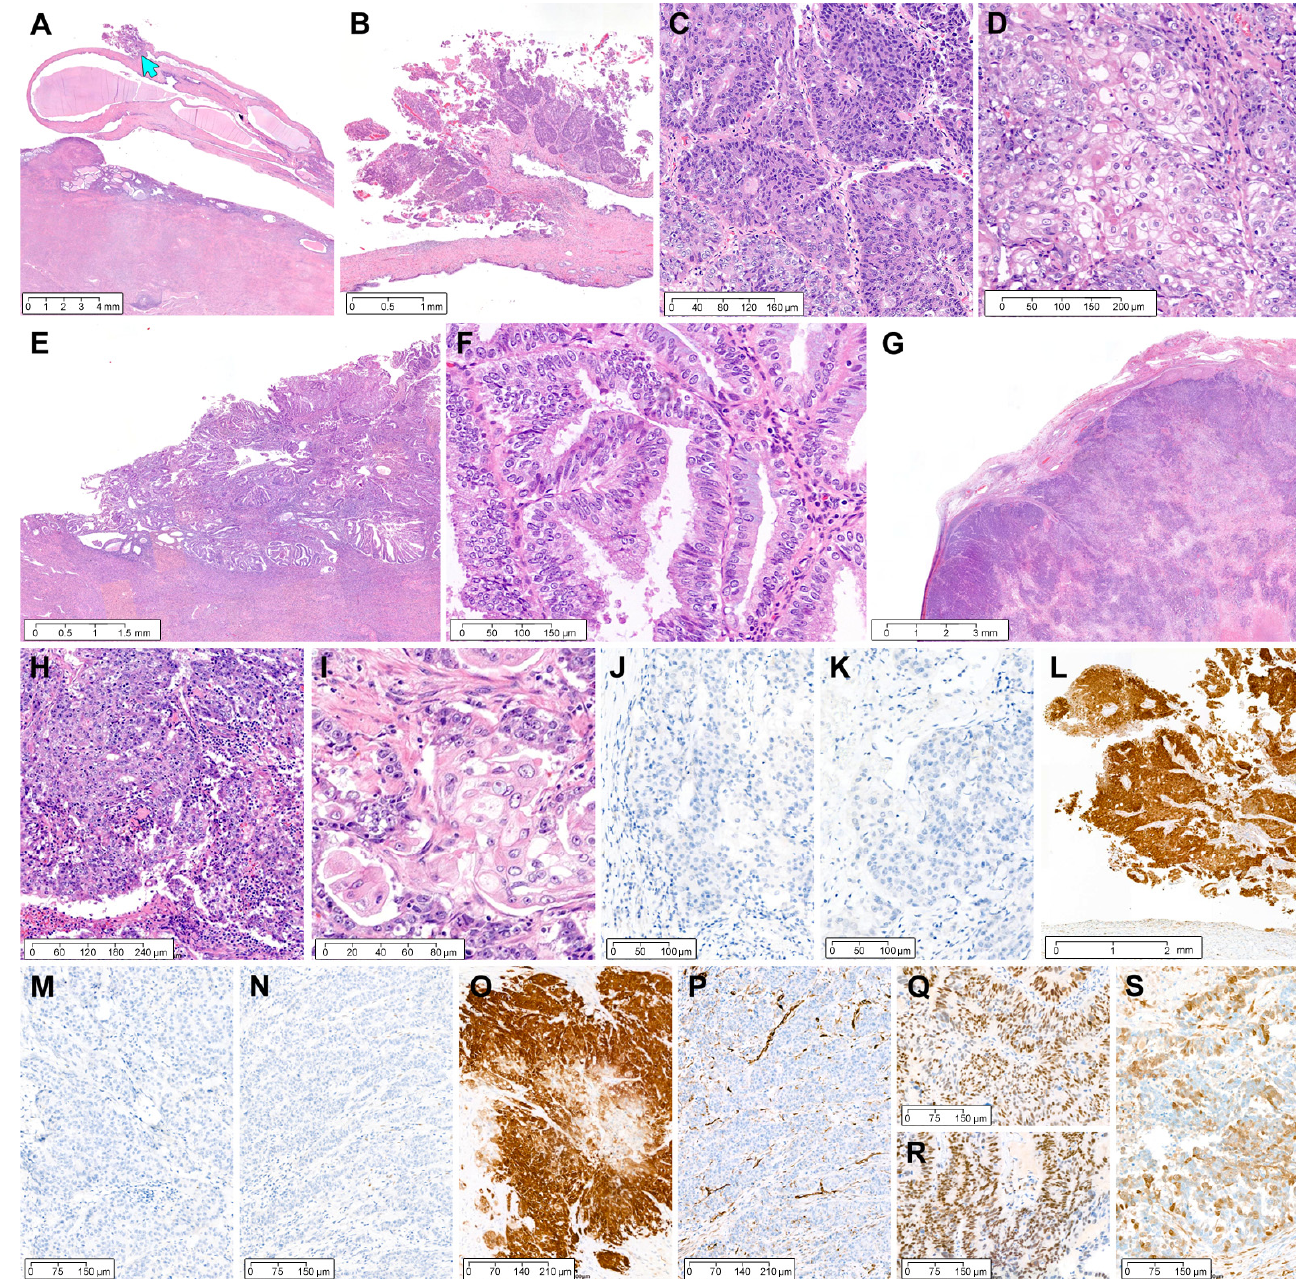
Figure 3. Grade 3 ovarian EC involving ECP: case 2. ( A ) The hysterectomy specimen shows an elongated ECP. EC (blue arrow) appears as an exophytic mass protruding from the surface of ECP. ( B – D ) EC involving ECP ( B ) superficially invades the stroma of the polyp up to 0.3 mm, ( C ) consists predominantly of solid sheets of tumor cells, and ( D ) exhibits severe nuclear pleomorphism, coarse chromatin, and prominent nucleoli. Foci of squamous differentiation are readily identifiable. ( E ) In the endometrial EC, well-differentiated glands are confluent and crowded. ( F ) Areas of mucinous differentiation are noted. ( G ) The ovarian EC demonstrates a diffuse infiltrative growth pattern with foci of geographic tumor necrosis. ( H ) The solid architecture occupies more than half of the tumor, compatible with grade 3 EC. ( I ) High-grade nuclear atypia and the presence of squamous differentiation are the same as those of EC involving ECP. ( J – S ) Immunohistochemically, EC involving ECP is negative for ( J ) estrogen receptor (ER) and ( K ) progesterone receptor (PR) and ( L ) positive for p16 with strong staining intensity. Ovarian EC is also negative for ( M ) ER and ( N ) PR and ( O ) uniformly and intensely positive for p16. ( P ) WT1 negativity excludes the possibility of serous carcinoma. ( Q – S ) Endometrial EC shows strongly positive expression for ( Q ) ER and ( R ) PR and ( S ) patchy p16